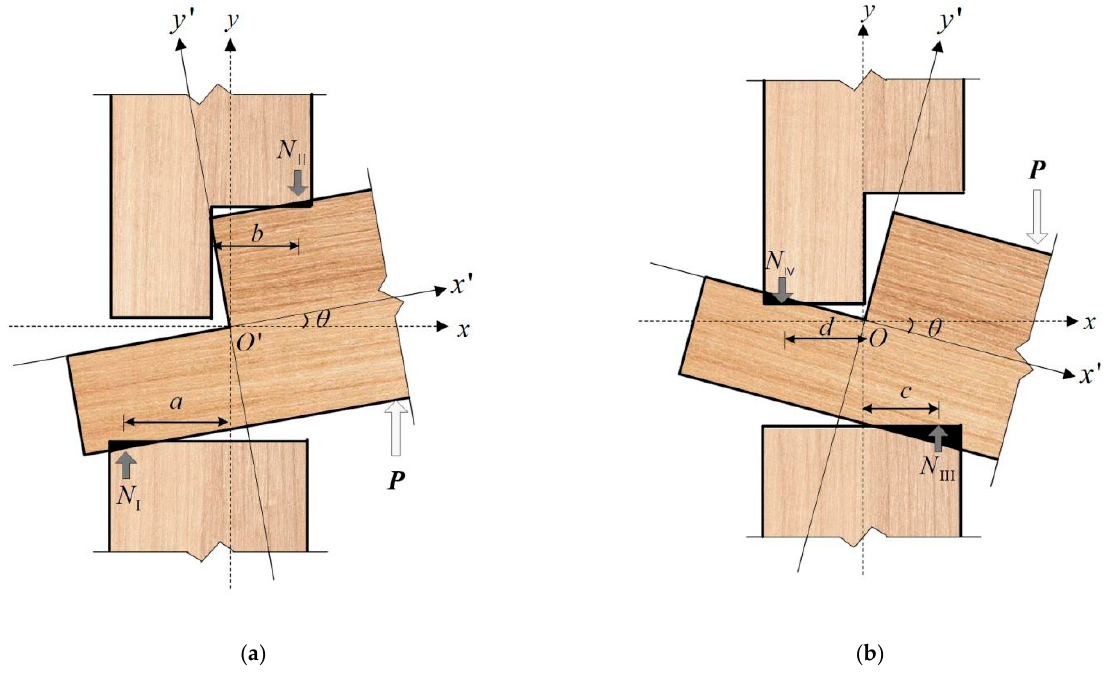
Figure 11. Compression force during rotation. ( a ) Positive rotation. ( b ) Negative rotation.